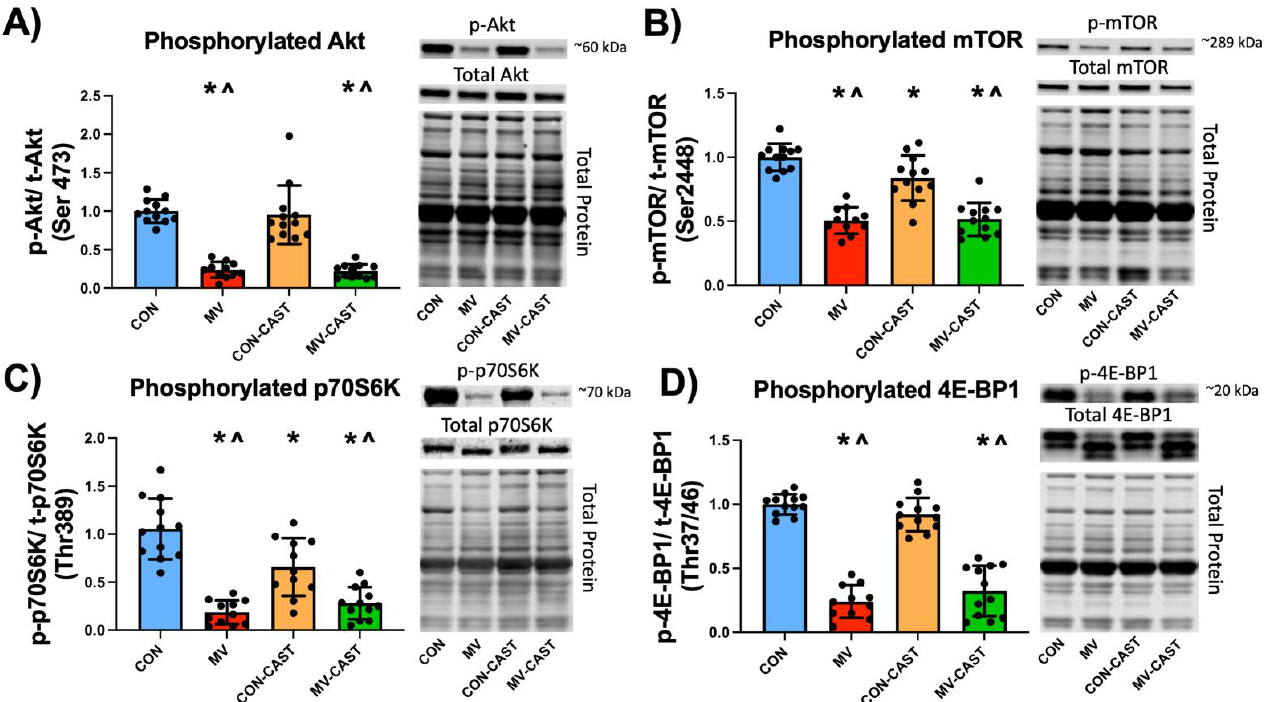
Figure 3. Markers of anabolic signaling via the Akt/mTOR pathway are decreased with MV. Nota- bly, preventing MV-induced activation of calpains was not able to rescue diminished Akt/mTOR signaling. Protein expression of ( A ) Phosphorylated Akt (Ser473), ( B ) Phosphorylated mTOR (Ser2448), ( C ) Phosphorylated p70S6 kinase (Thr389), and ( D ) Phosphorylated 4E-BP1 (Thr37/46). * = significantly different from CON; ^ = significantly different from CON-CAST.